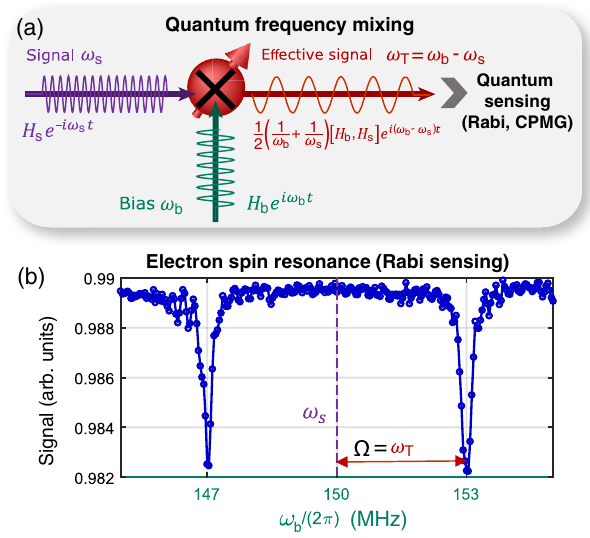
FIG. 1. (a) Quantum frequency mixing schematic. The effec- tive Hamiltonian (red) emerges from the frequency mixing of the signal (purple) and bias (green) Hamiltonians. The effective Hamiltonian frequency ω T can be probed experimentally. (b) Electron spin resonance (ESR) experiment to probe ω T using an ensemble of NV centers. We sweep the bias field frequency ω b to detect the presence of a signal field at ω 2 π Þ 150 MHz, which is not in the accessible range of s ¼ ð typical sensing methods. We observe a resonance when the down-converted frequency ω T ¼ (cid:2)ð ω s − ω b Þ matches the probing drive amplitude at Ω ¼ ð 2 π Þ 3